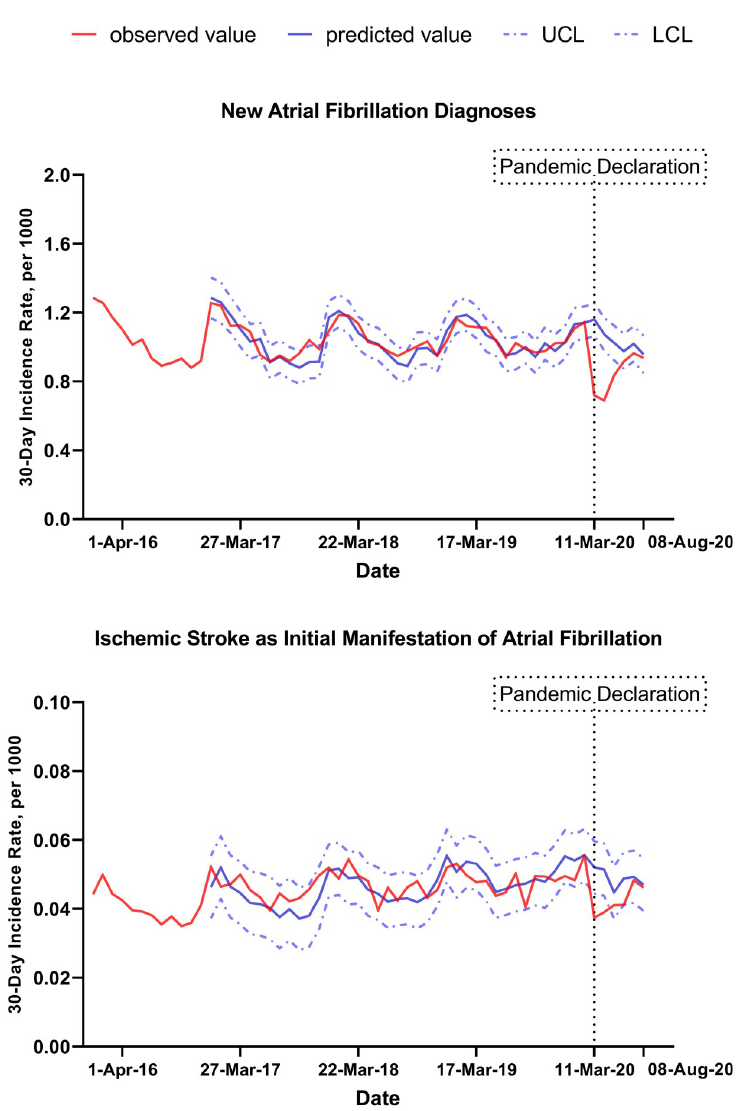
Fig 1. Observed and predicted new atrial fibrillation diagnoses, overall sample. Abbreviations: UCL, upper confidence limit; LCL, lower confidence limit. The upper panel shows trends in new atrial fibrillation diagnoses per 1000 individuals for 30-day intervals, from 01/02/2016 to 09/06/2020. The lower panel shows trends in ischemic strokes as initial manifestation of atrial fibrillation per 1000 individuals for 30-day intervals, from 01/02/2016 to 09/06/ 2020. Solid red lines represent observed values. Solid blue lines represent predictions from ARIMA models the absence of the COVID-19 pandemic. In other words, they represent trends in AF diagnosis that would have been observed if there had not been a change in AF diagnoses following the COVID-19 pandemic. Dashed blue lines represent confidence intervals.